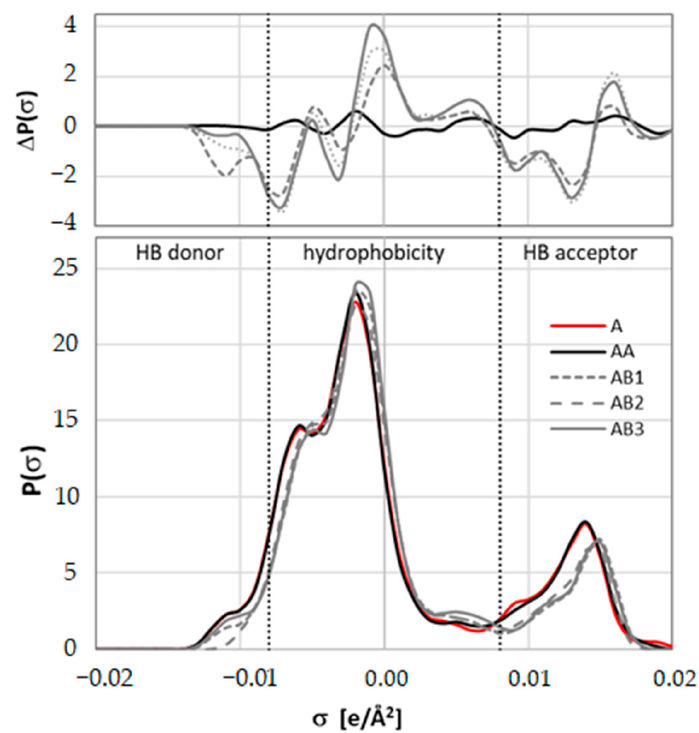
Figure 9. The σ -profiles characteristics of caffeine (A), caffeine dimer (AA), caffeine-choline chloride (AB1), caffeine-glycerol (AB2) and caffeine-water (AB3). Bottom panel represents electron charge density profiles obtained using “ mcos ” files for all pairs graphically presented in Figure 8. Top panel presents relative profiles with respect of monomeric caffeine.